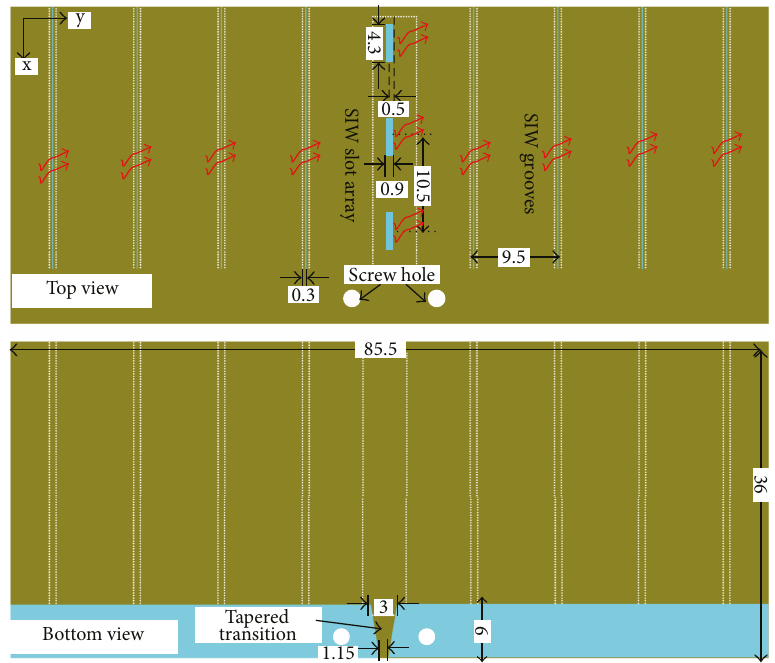
Figure 1: The layout of the proposed antenna. All the dimensions are in mm.